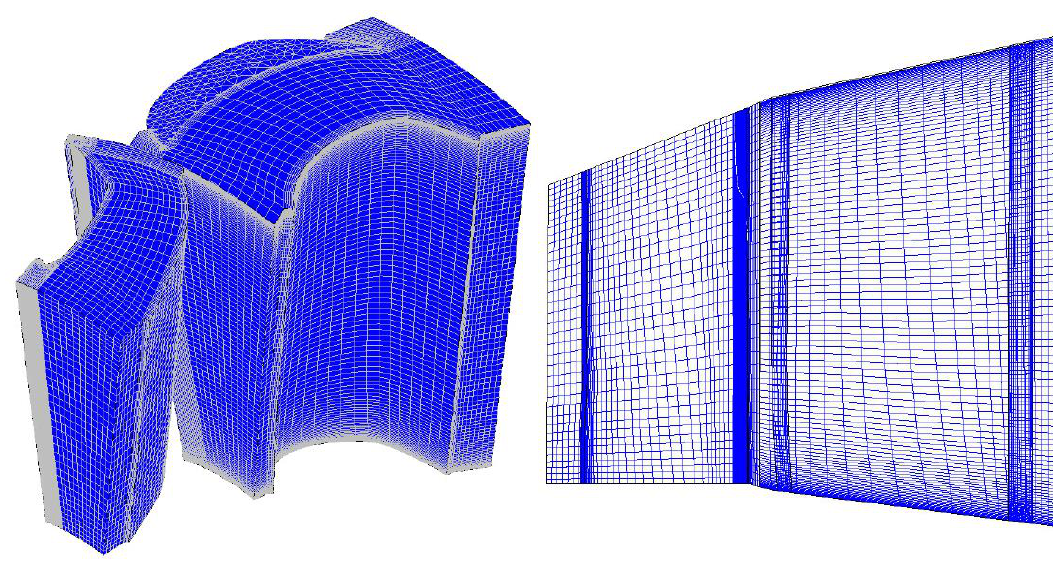
Figure 32. Mach number and entropy contours (85% spanwise).